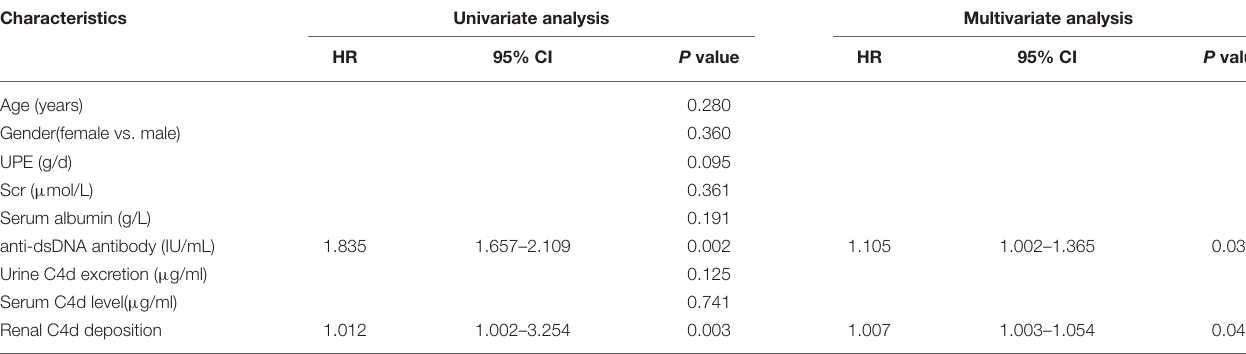
TABLE 6 | Univariate and multivariate Cox regression analysis for predictors of the disease relapse in LN patients. Characteristics